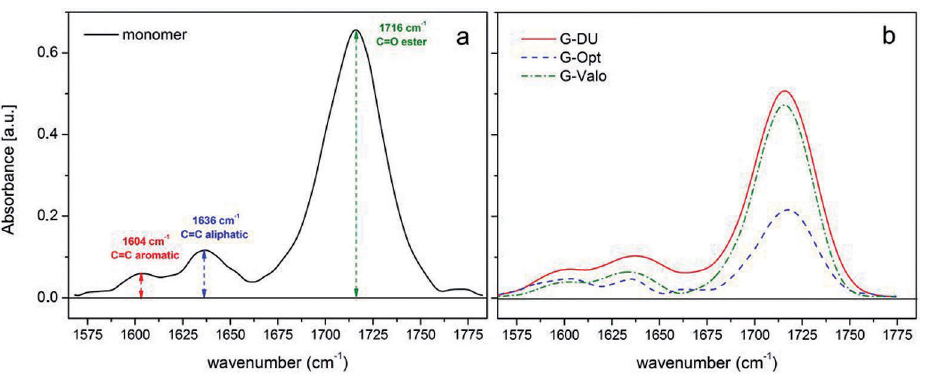
Figure 4- Fourier-transform infrared spectroscopy (FTIR) spectra of uncured resin (a) and cured giomer (b) by using different light sources at 2 mm depth within a narrow range of wavenumber